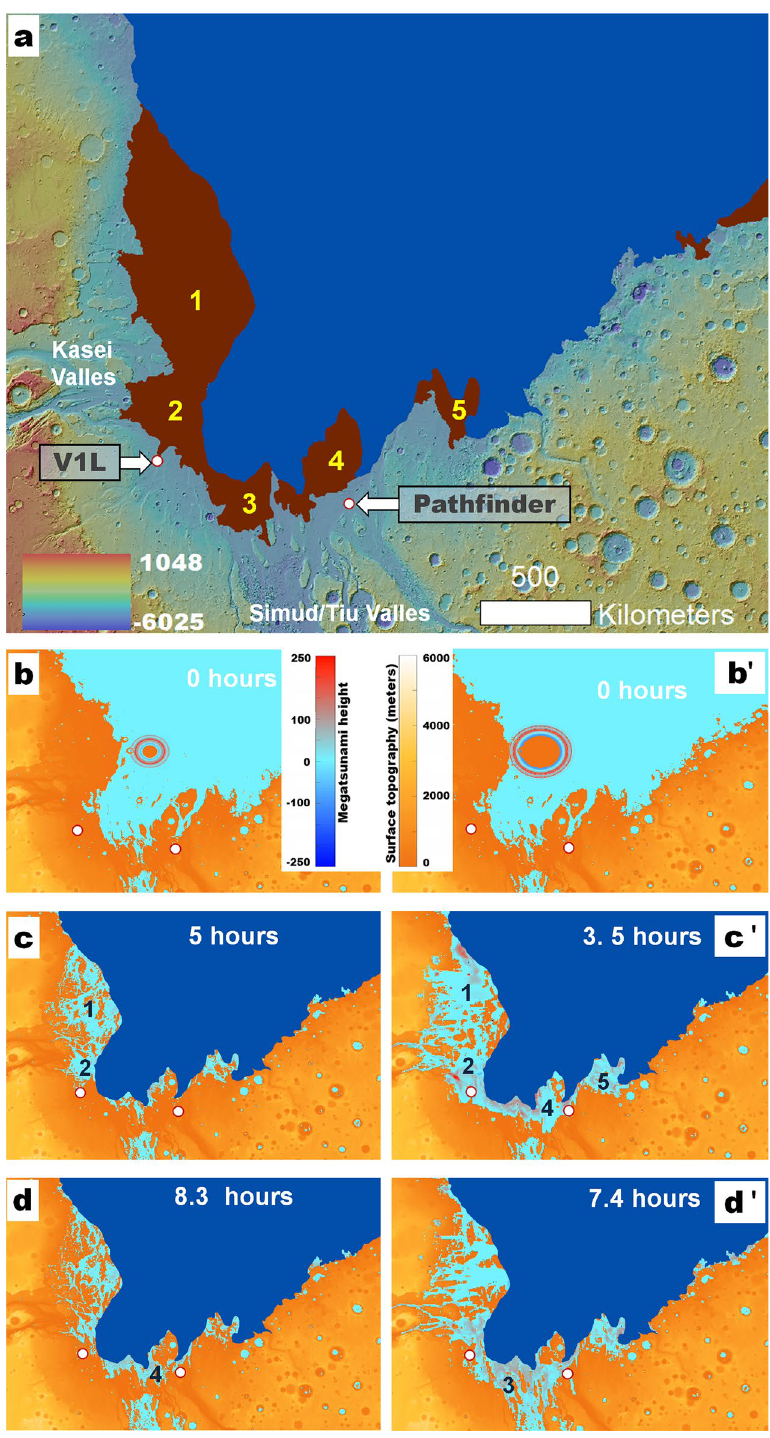
Figure 5. (a) View of the Chryse Planitia region. The dark blue area is a reconstruction of the northern ocean with a paleoshoreline at − 3800 m. The adjoining brown areas show the mapped older megatsunami areas of overland deposition (lHl 1 ) mapped by Rodriguez, et al. 6 . The locations of the V1L and the Mars Pathfinder (MPF) Lander are indicated. Numbers 1–5 identify the megatsunami’s largest lobes. (b–d ) Weak Ground (WG) simulation (zero residual shear strength), 3 km asteroid (supplementary movie 1). (b’–d’ ) Strong Ground (SG) simulation, (0.01 MPa residual shear strength), 9 km asteroid (supplementary movie 4). The simulations show megatsunami propagation directions and extents that closely match the mapping shown in panel ( a ). Both simulations predict inundations over the V1L site as well as close to (WG simulation) or over (SG simulation) the Pathfinder site. All the panels use MOLA DEM bases (460 m per pixel, credit: MOLA Science Team, MSS, JPL, NASA). The topographic ranges in the DEMs shown in the simulation panels ( b–d , b’–d’ ) represent the regional relief with a zero-meter base. We produced this figure using Esri’s ArcGIS 10.3 (http:// www. esri. com/ softw are/